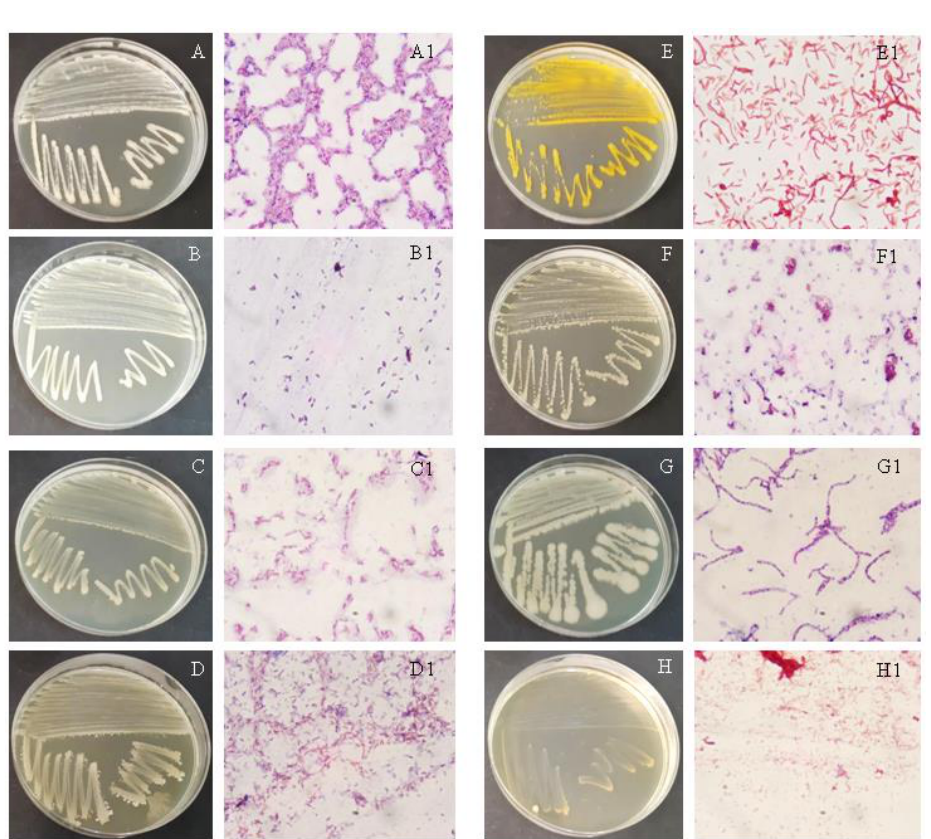
Figure 2. Obtained pure culture by streaking method and microphotographs of Gram staining of bacteria isolates I1 ( A , A1 ), I2 ( B , B1 ), I3 ( C , C1 ), I4 ( D , D1 ), I5 ( E , E1 ), I6 ( F , F1 ), I7 ( G , G1 ), and I8 ( H , H1 ), M = 1000×. Table 3. Morphology of isolated colonies, I1 – I15.